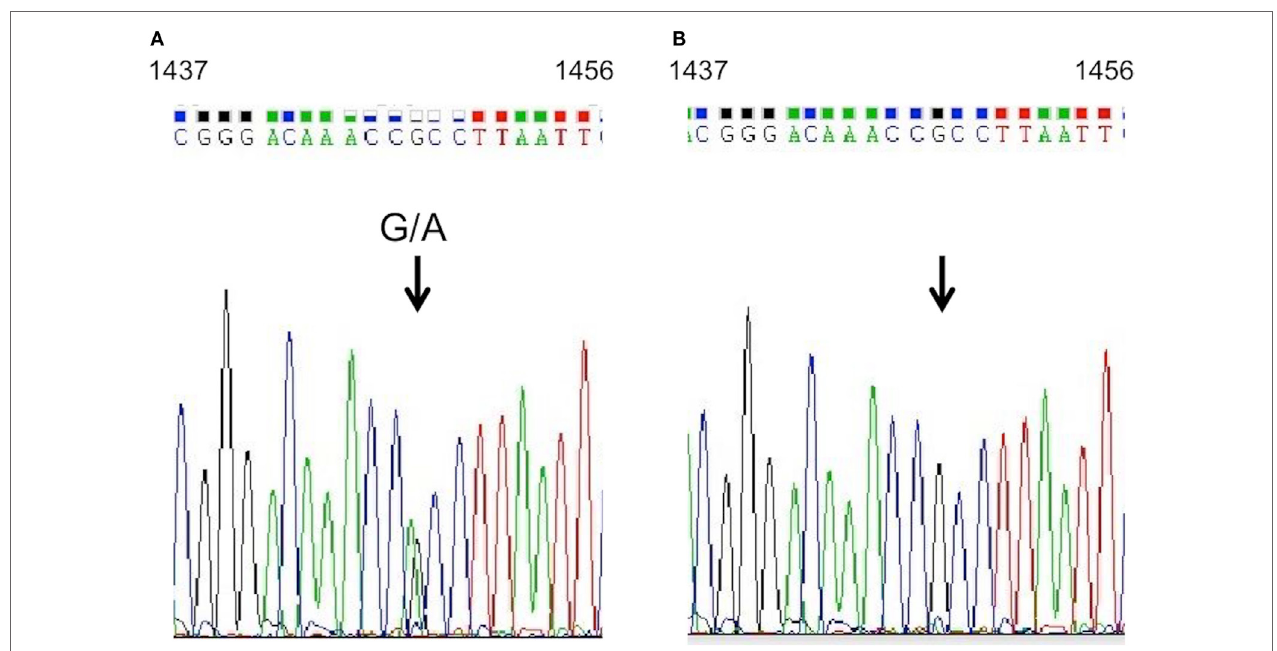
FIGURe 4 | KEAP1 gene analysis . Sequencing analysis of KEAP1 in genomic DNA extracted from the proband’s peripheral blood leukocytes. A heterozygous guanine-to-adenine transition at position 1448 (indicated by arrows) was identified in the proband (a) , and a wild-type sequence was shown in her mother (B) .